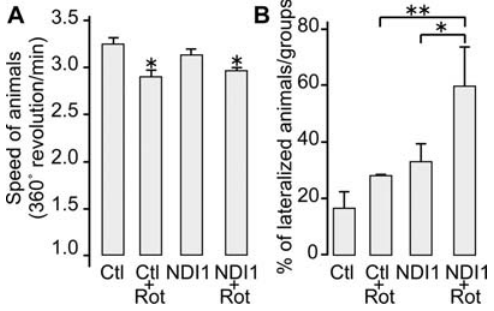
Figure 5. Behavioral tests of rotenone-exposed rats. Rotenone exposure was carried out as described in Figure 2. Each rat was placed in a round bucket after apomorphine administration and the movement was video-taped for 30 min. Data were analyzed for the four groups; Ctl (n=3), Ctl + Rot (n=14), NDI1 (n=5) and NDI1 + Rot (n=20). n=number of animals. A: Speed of movement of rats was calculated as the number of full turns per minute. B: The number of rats exhibiting fully lateralized turning in either direction was counted. Histograms represent percentage of animals turning only in one direction. (*: p , 0.05; **: p , 0.01). All values are presented with standard